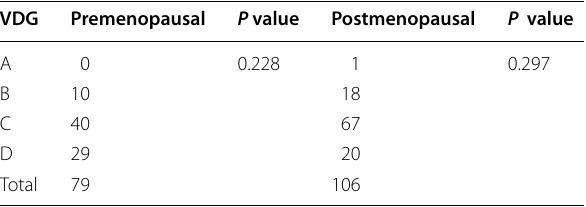
Table 4 Risk of carcinoma in different VDG in premenopausal and postmenopausal age groups